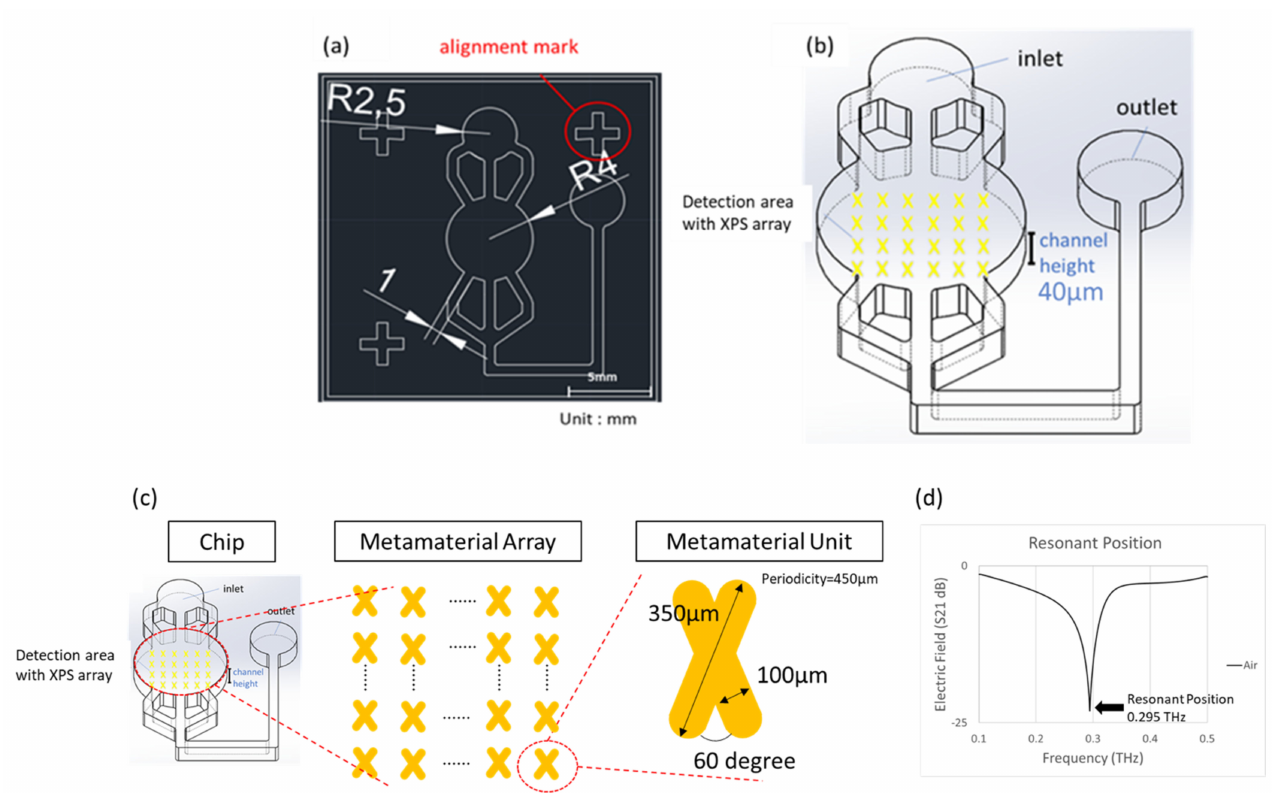
Figure 1. ( a ) The design of the microfluidic system. ( b ) Perspective view of the microfluidic system. ( c ) The design of the XPS metamaterial. ( d ) Simulation result shows a resonant dip at frequency of 0.295